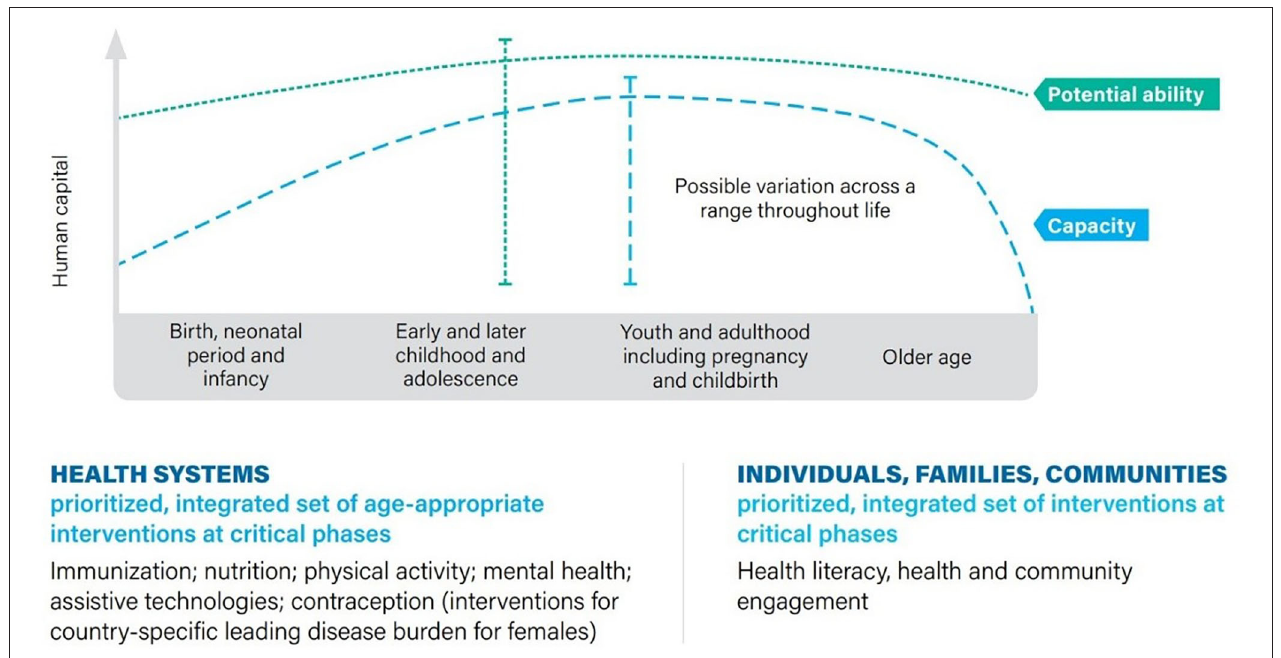
FIGURE 2 | Increasing human capital throughout life through an integrated set of evidence-based interventions. Source: GPW13 (2).